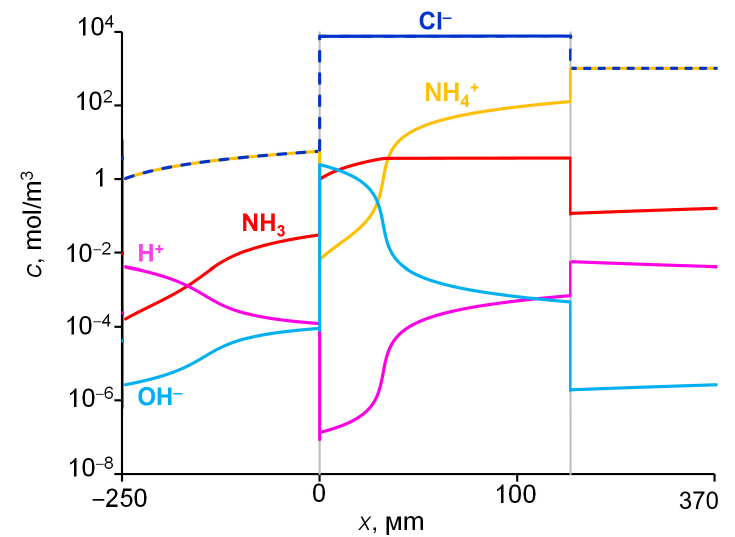
Figure 7. Distribution of ion concentration in the system under study at 1 M NH 4 Cl solution. Simulation with the input parameters presented in Table 1.